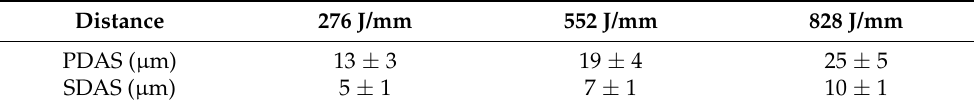
Figure 6. Illustration of PDAS and SDAS structure: ( a ) PDAS structure; ( b ) SDAS structure. Table 4. Size of primary dendrite arm spacing and secondary dendrite arm spacing was measured by 3 heat inputs.